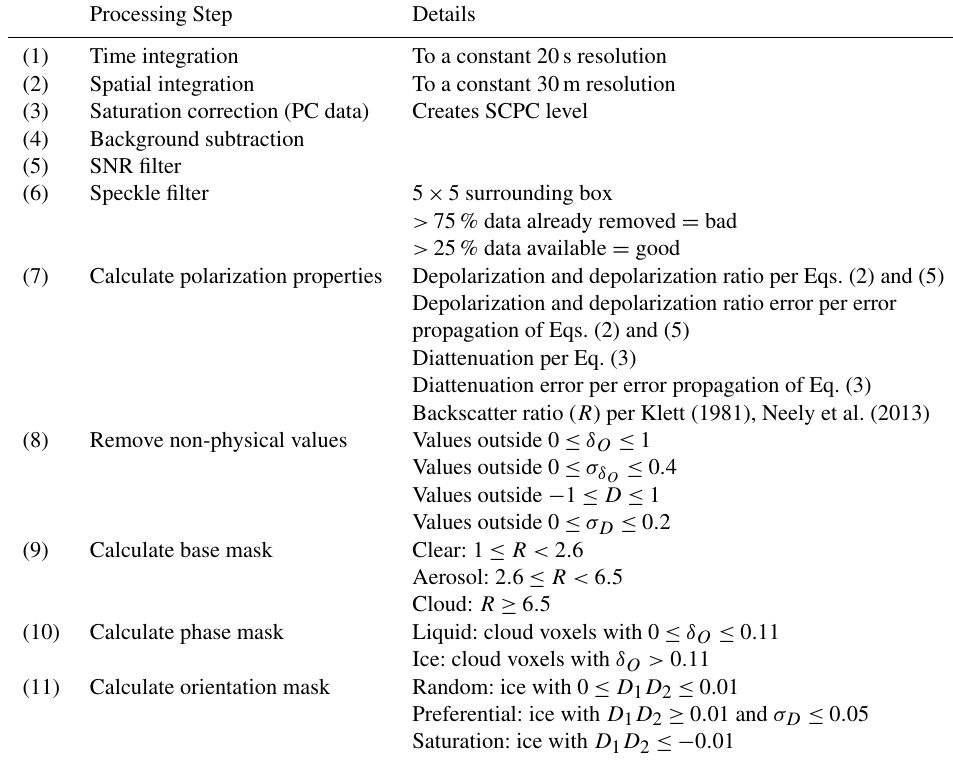
Table 2. A summary of the data processing steps taken to create the data masks desired for CAPABL. The processing for each data type – analog (An), photon counting (PC), and saturation-corrected photon counting (SCPC) – is constant except where noted. Note that the depolarization and diattenuation error equation are calculated per standard propagation of error techniques taking a Taylor series expansion of Eqs. (2) and